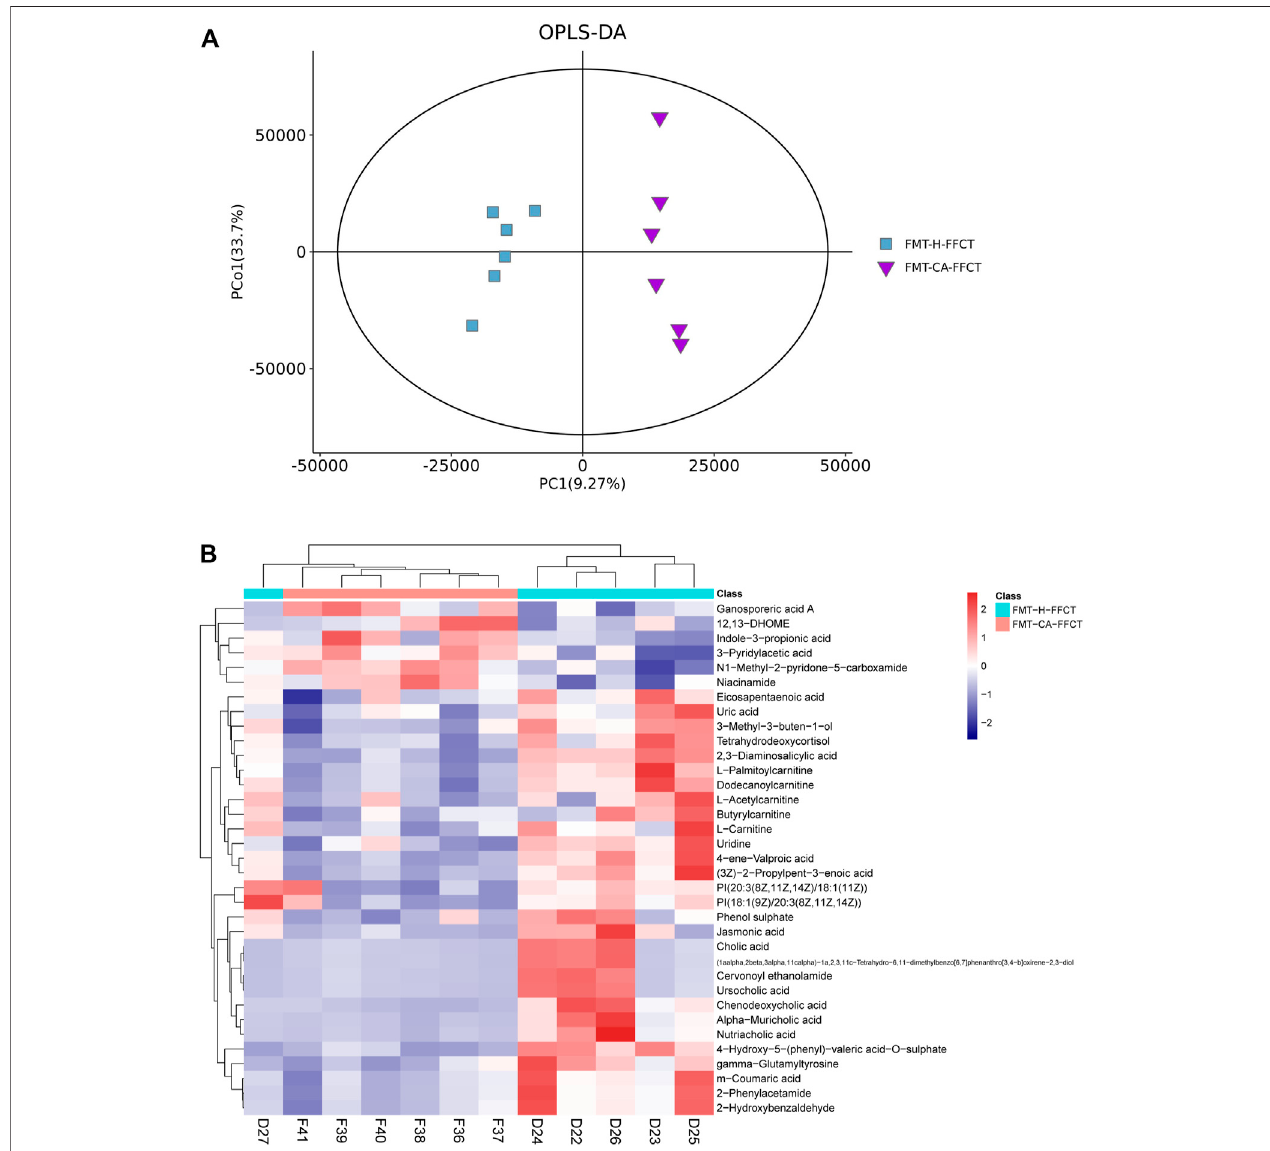
FIGURE4| MassspectrumofserummetabolisminFMTmice. (A) OPLS-DAscoreplotoftheFMT-CA-FFCTandFMT-H-FFCTgroups. (B) Heatmapofthetop50 different metabolites between the FMT-CA-FFCT and FMT-H-FFCT groups ( p < 0.05).